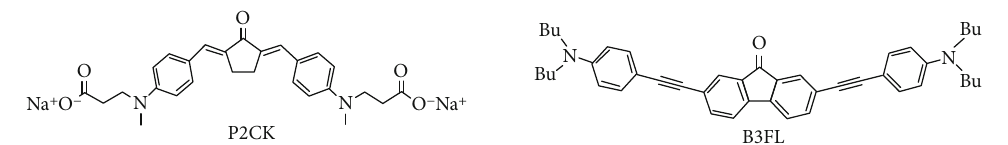
Figure 9: Structural formulas of TPA PIs. Here, P2CK is PI-soluble in water, while B3FL is soluble in organic